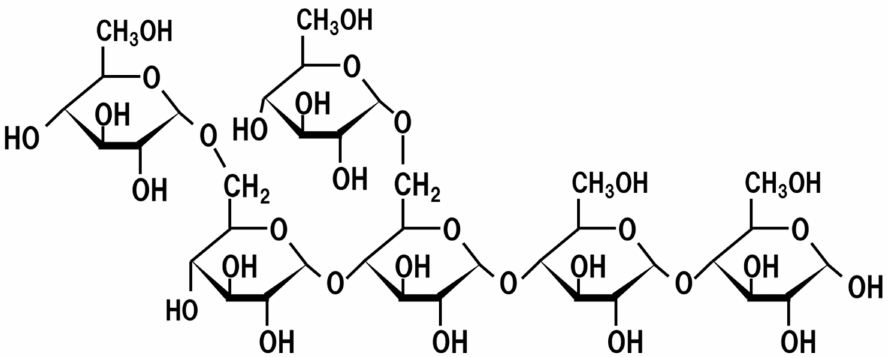
Figure 4. Chemical structure of resistant gluco-oligosaccaride.